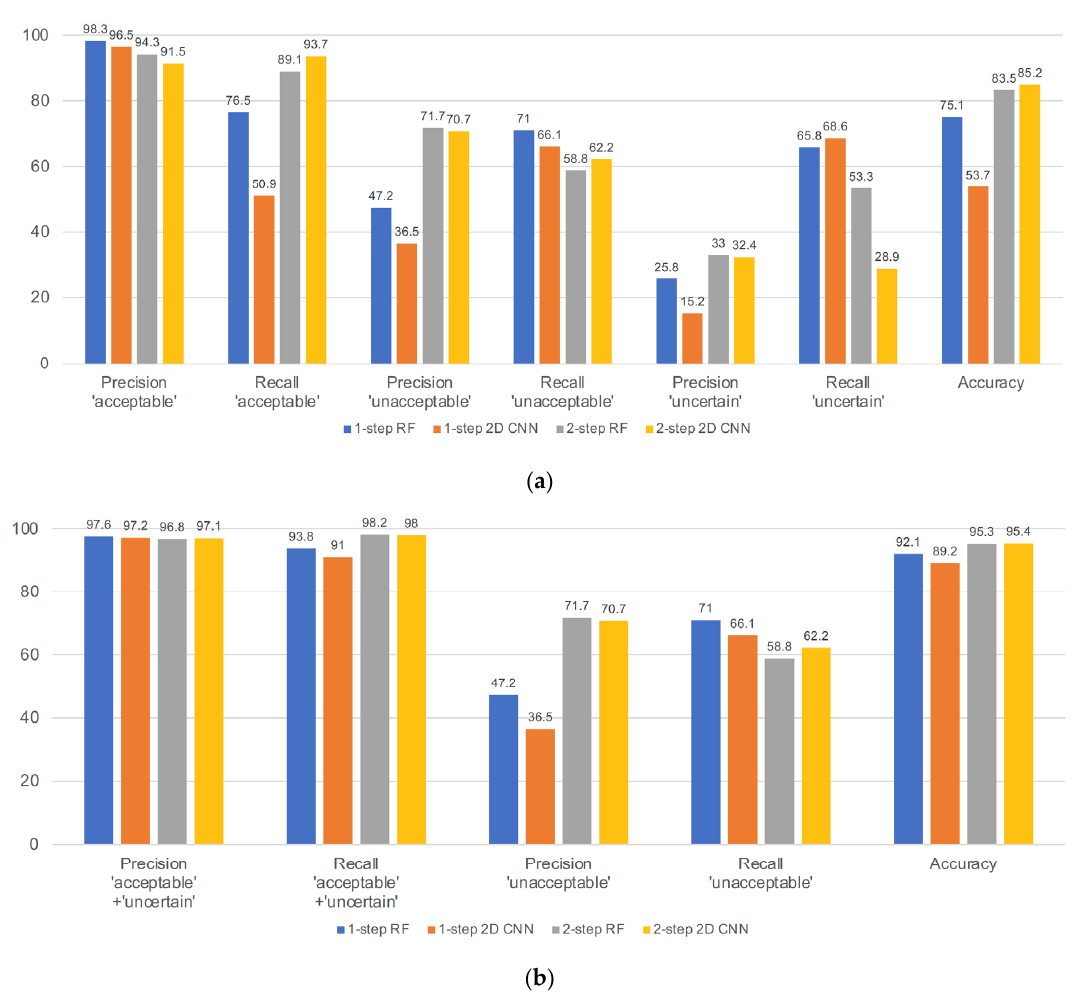
Figure 7. Precision, recall, and accuracy of the 4 approaches: ( a ) performance based on the original three classes; ( b ) performance based on merging the acceptable and uncertain classes. RF: random forest; 2D CNN: two-dimensional convolutional neural network. Unit = %.